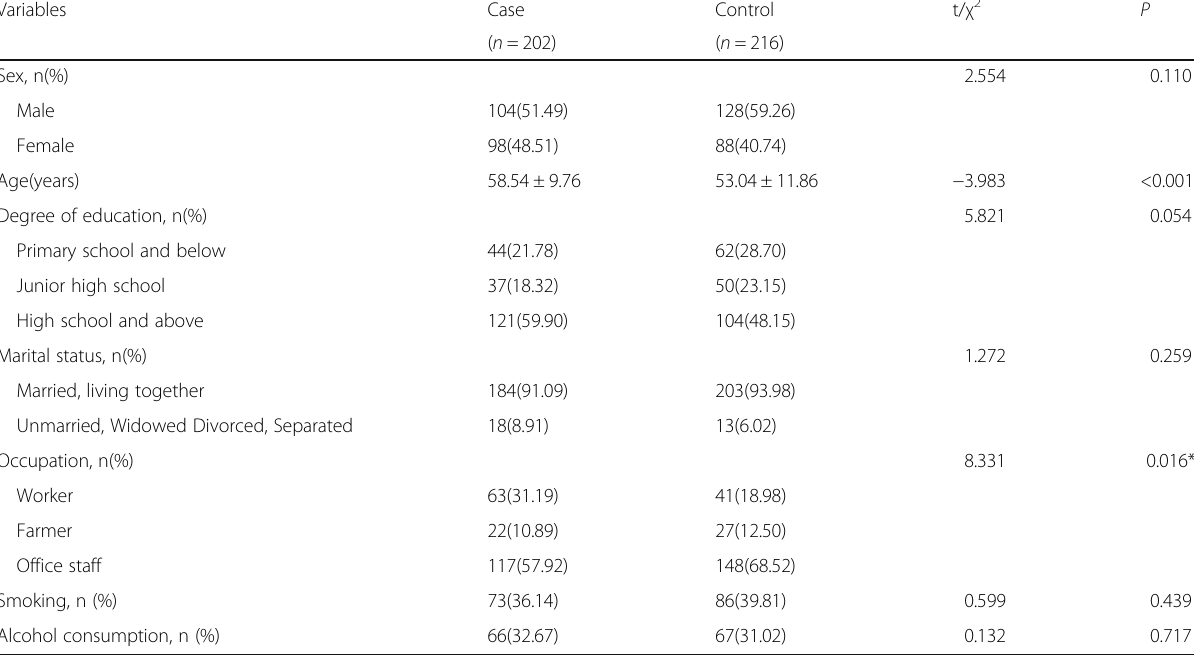
Table 2 Demographic characteristics of the study participants